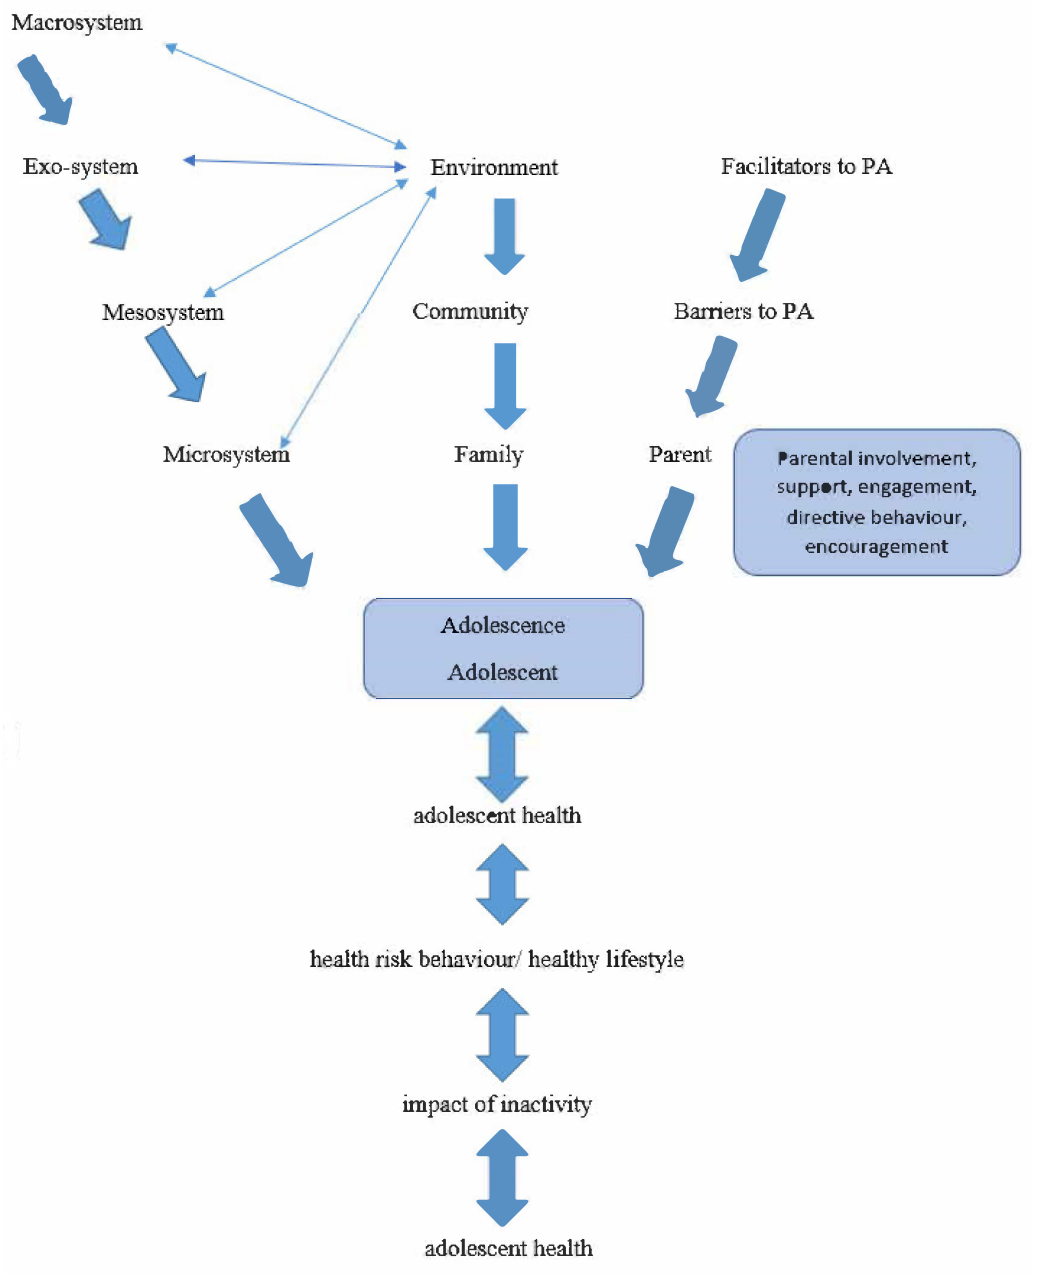
Figure 3. Environmental factors impacting